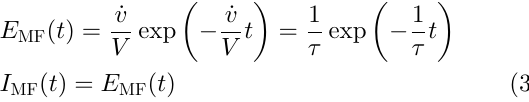
Fig. 1. Exit (top) and internal (bottom) residence time distri- butions for static- and mixed-fuel reactors of equal discharge and cycle times τ dis = τ cycle as function of